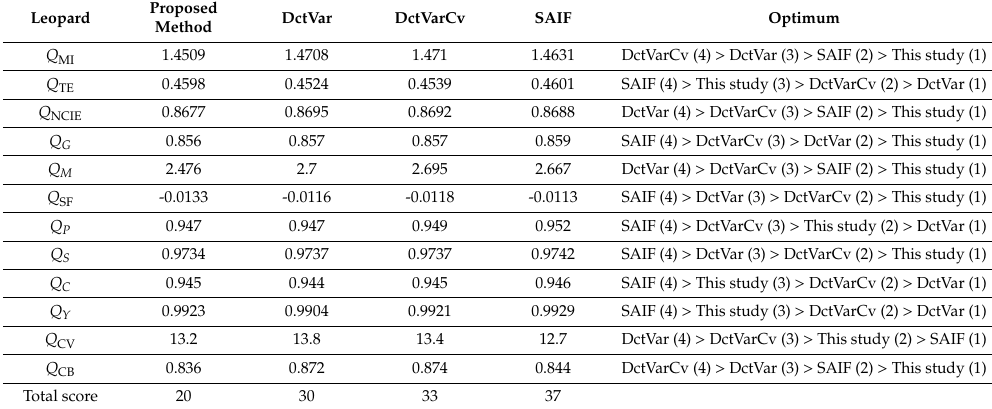
Table 4. List of leopard fusion results and fusion quality